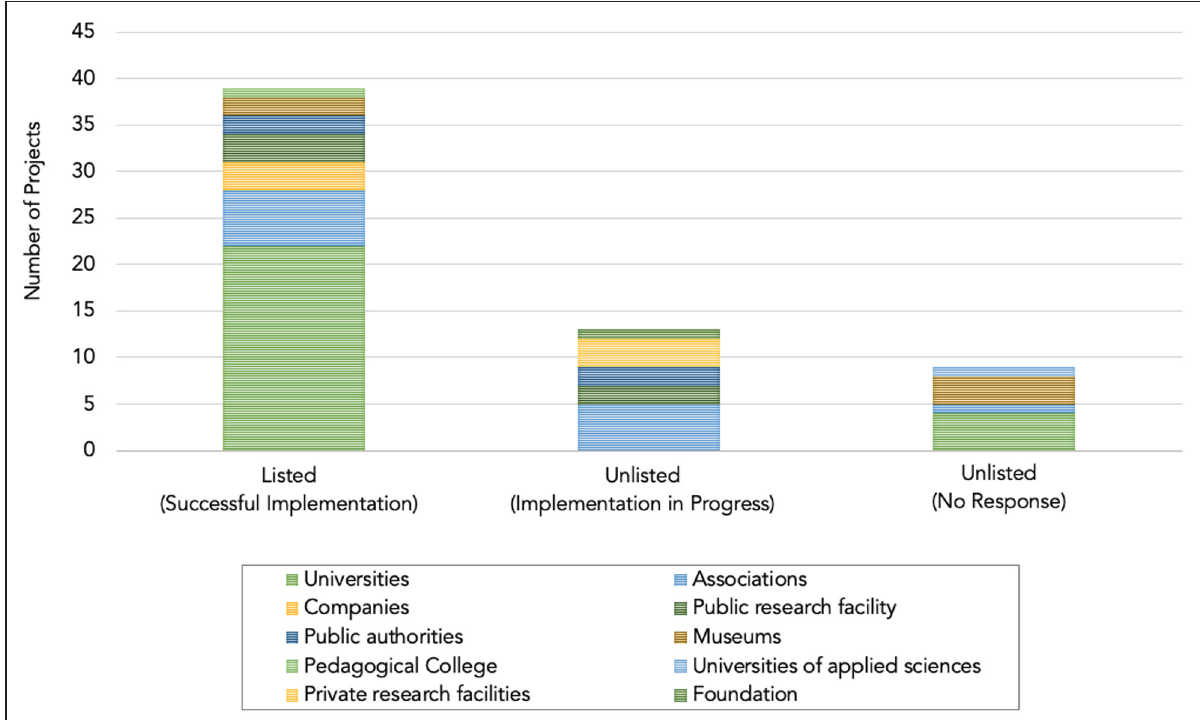
Figure 2: Current status of the implementation of the quality criteria by projects in absolute numbers as of June 26, 2019. The institutional backgrounds of the project leaders are represented by different color